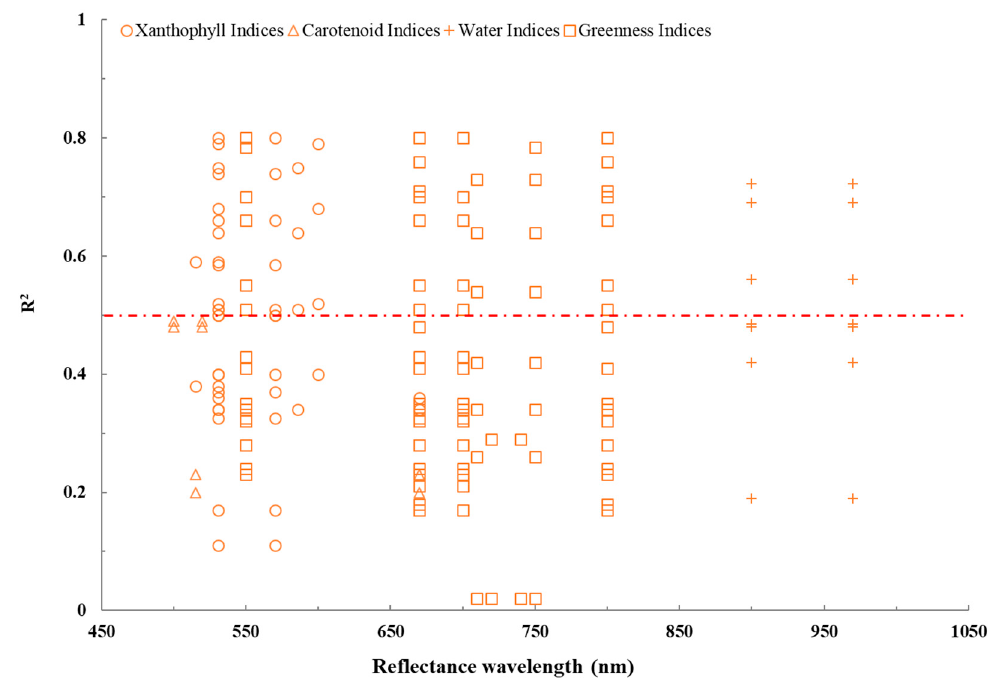
Figure 3. Relationships between R 2 and wavelength of different VIs clusters under drought stress. The red line indicates that R 2 > 0.50.